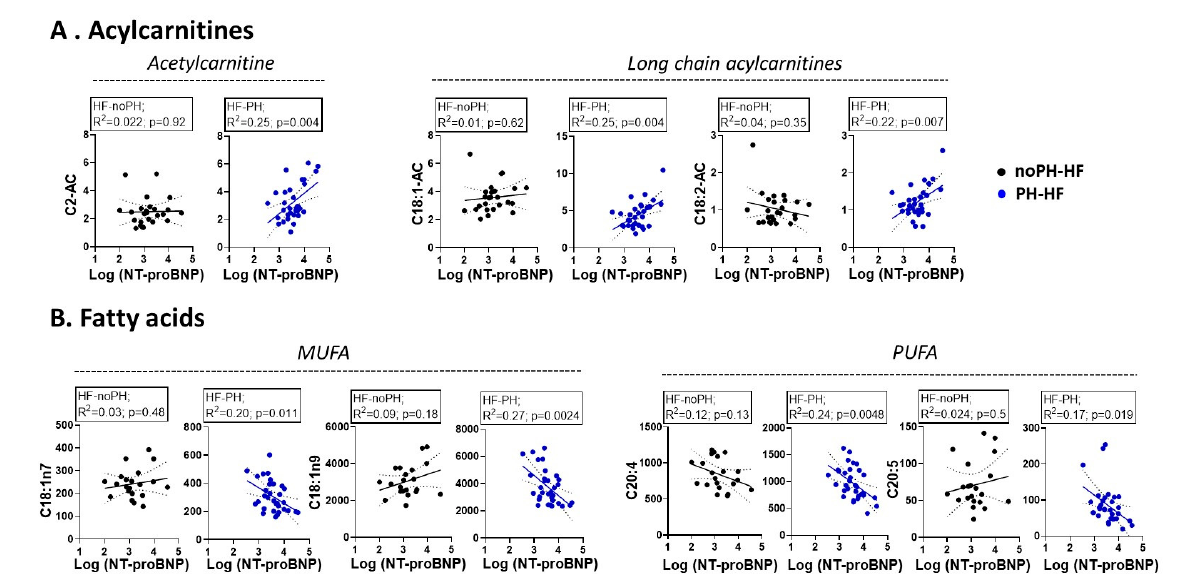
Figure 3. Acylcarnitines and fatty acids significantly correlate with NT-proBNP in PH-HF but not in noPH-HF patients. Pearson correlation analysis between NT-proBNP and ( A ) acylcarnitines, ( B ) FA (MUFA and PUFA) in noPH-HF (black) or PH-HF (blue) patients. The dotted lines indicate the 95% confidence intervals.